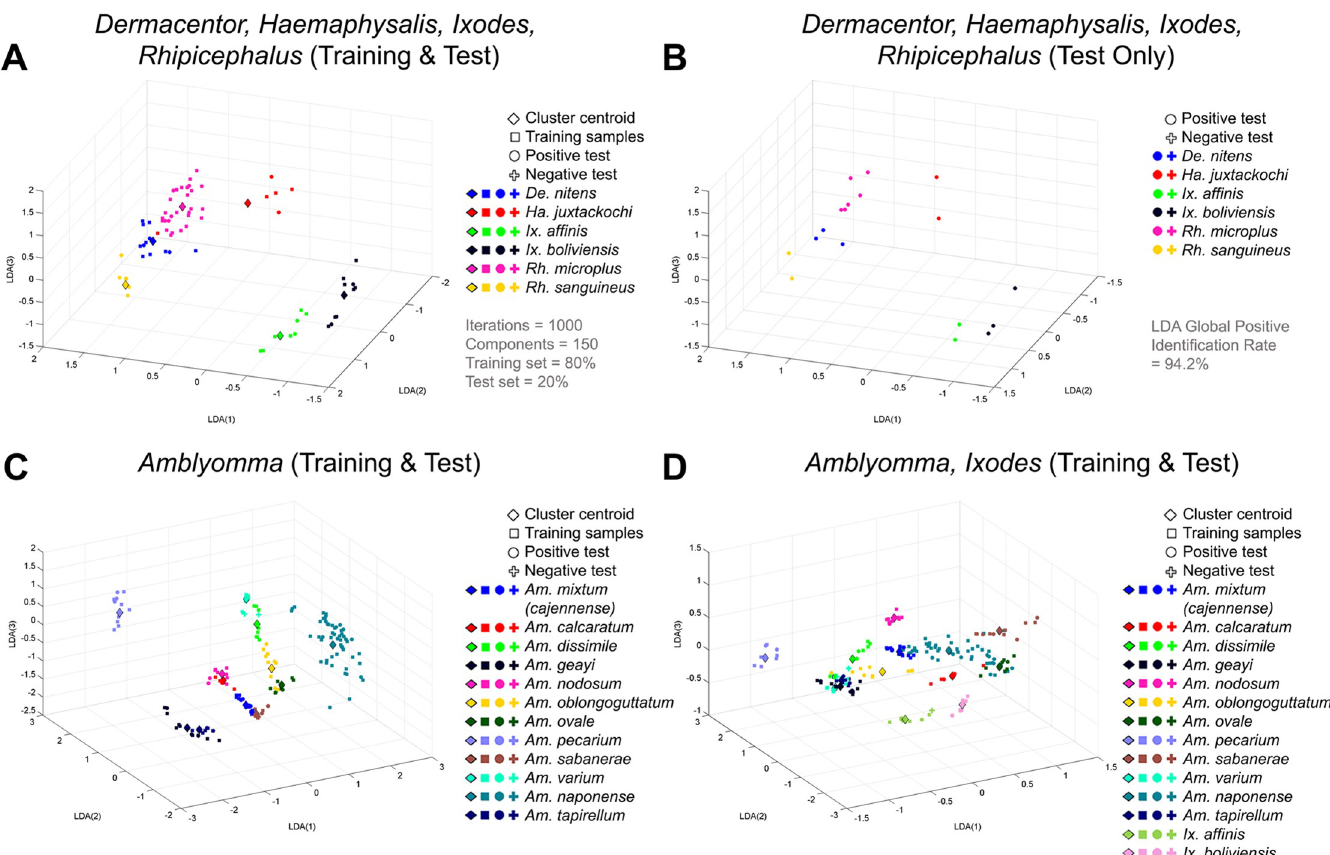
Fig 4. Linear Discriminant Analysis (LDA) applied to spectra from tick species of the genera Amblyomma , Dermacentor , Haemaphysalis , Ixodes and Rhipicephalus . The plots show (A) the training and test sets for species in the Dermacentor , Haemaphysalis , Ixodes and Rhipicephalus genera projected over the first three components of the LDA, as well as (B) only the test set for better visualization; and also the training and test sets for (C) the Amblyomma genus alone, as well as (D) the Amblyomma genus compared to the Ixodes genus. These 3D plots represent only one of the 1000 Monte Carlo iterations performed with the algorithm. The supervised LDA algorithm had a 94.2% global positive identification rate.